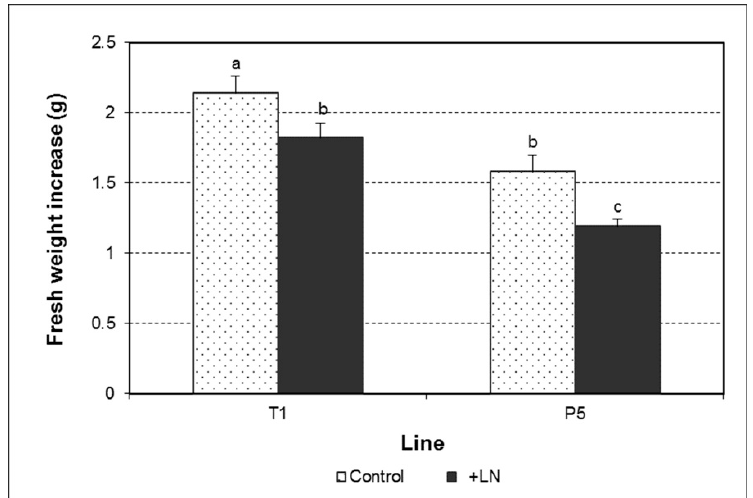
Figure 5. Fresh weight increase of olive embryogenic cultures control and derived from cryopreserved somatic embryos of the lines T1 and P5. Data assessed eight weeks after initiation in maturation conditions. Data represent the mean ± SEM. Different letters indicate significant differences by the LSD test with a significance level of 0.05.